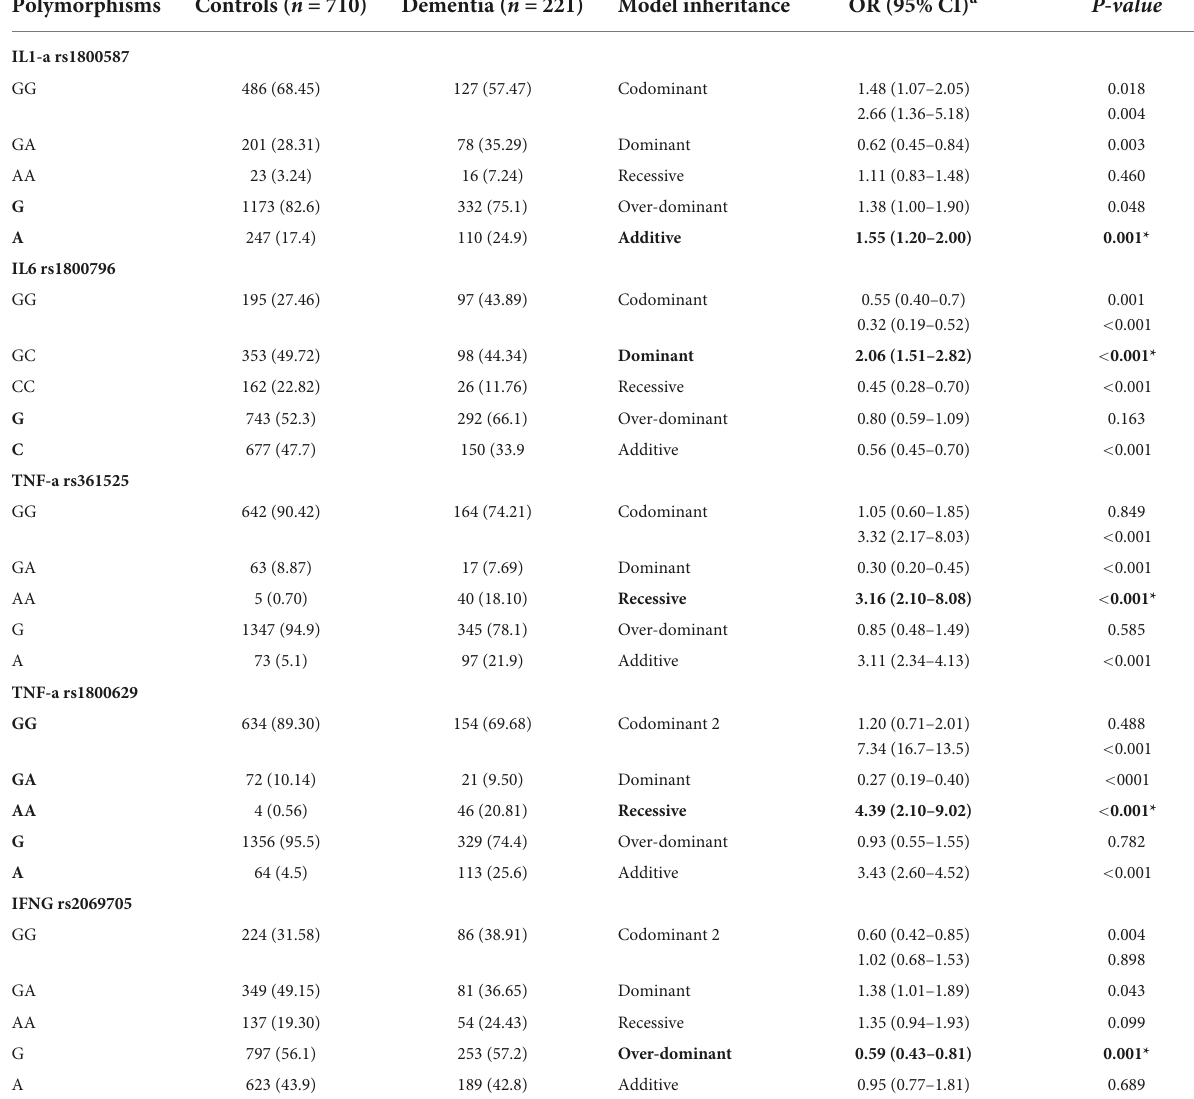
TABLE 3 The genotypic and allelic frequency distributions of the genes included in the study.